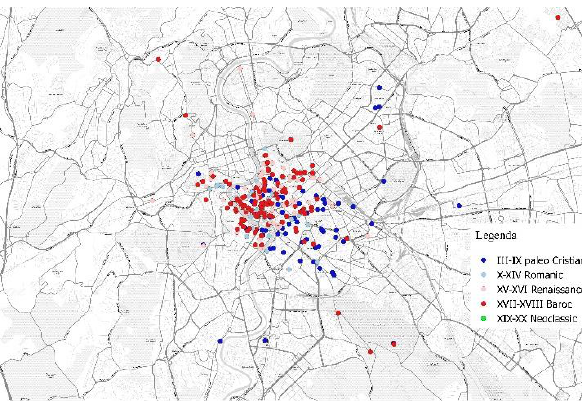
Figure 4. Distribution of the Churches according to their